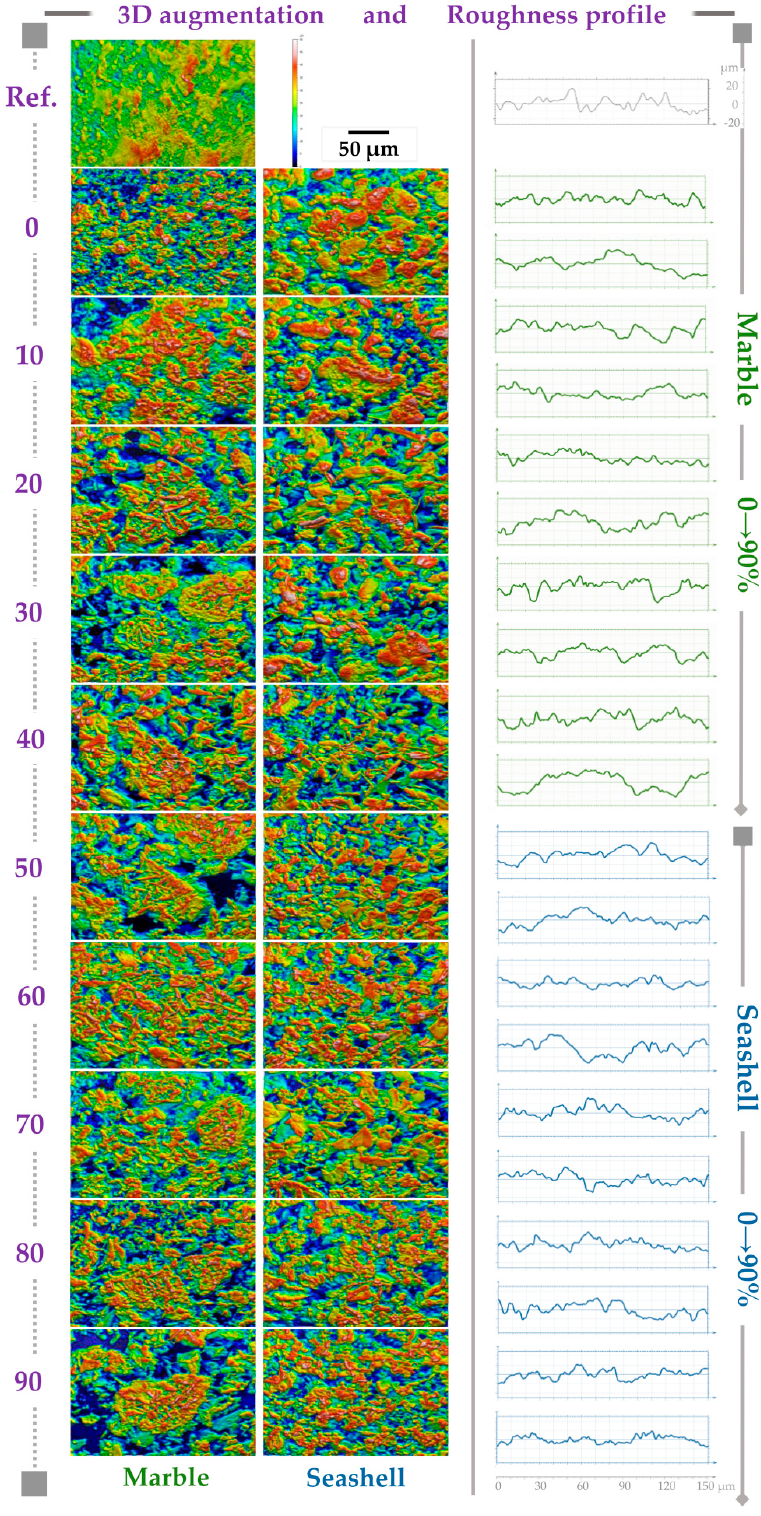
Figure 4. 3D surface topology reconstruction on the basis of SEM micrographs processing via Mountains Map software and roughness profiles assessment. Images were recorded at 500× magnification. Top center image: Scale bar (50 μ m) for all micrographs. For all roughness profiles, the scale bar is provided on the right side (up and down) of the figure.